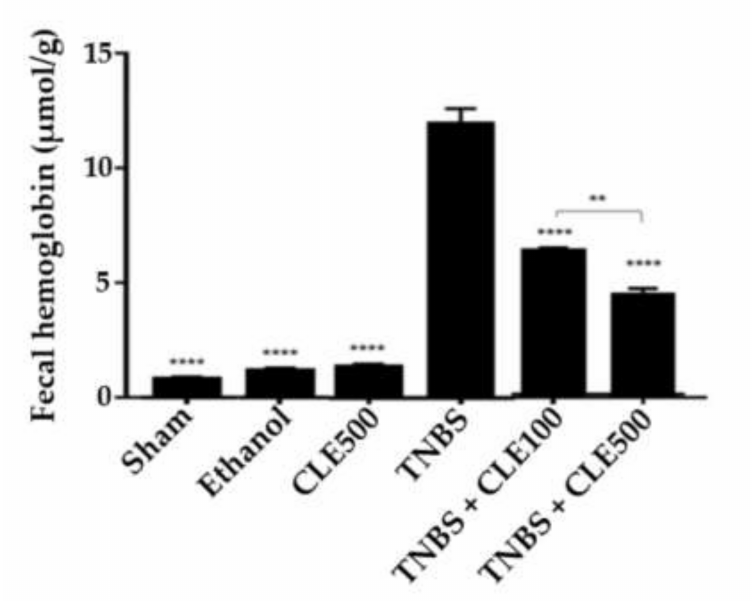
Figure 3. CLE influence on fecal hemoglobin levels in IBD context. Legend: One-way ANOVA and Tuckey’s post hoc test; ** p < 0.01, **** p < 0.0001 in comparison to the TNBS group or between groups. Abbreviations: CLE, C. cardunculus L. extract; TNBS, 2,4,6-trinitrobenzene sulfonic